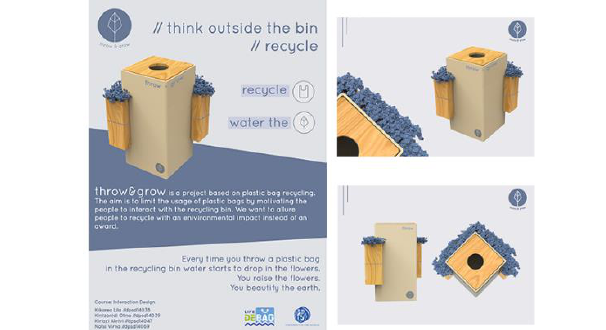
Figure 7. Throw and Grow concept and